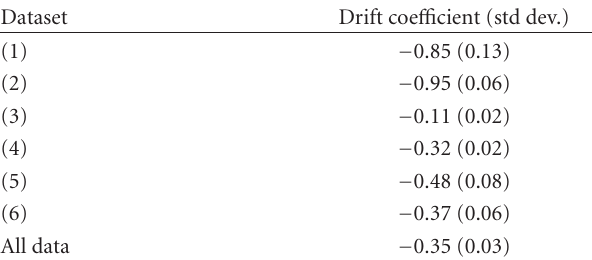
Table 1: Estimated drift coe ffi cients for the model of drift-di ff usion describing cell migration toward the